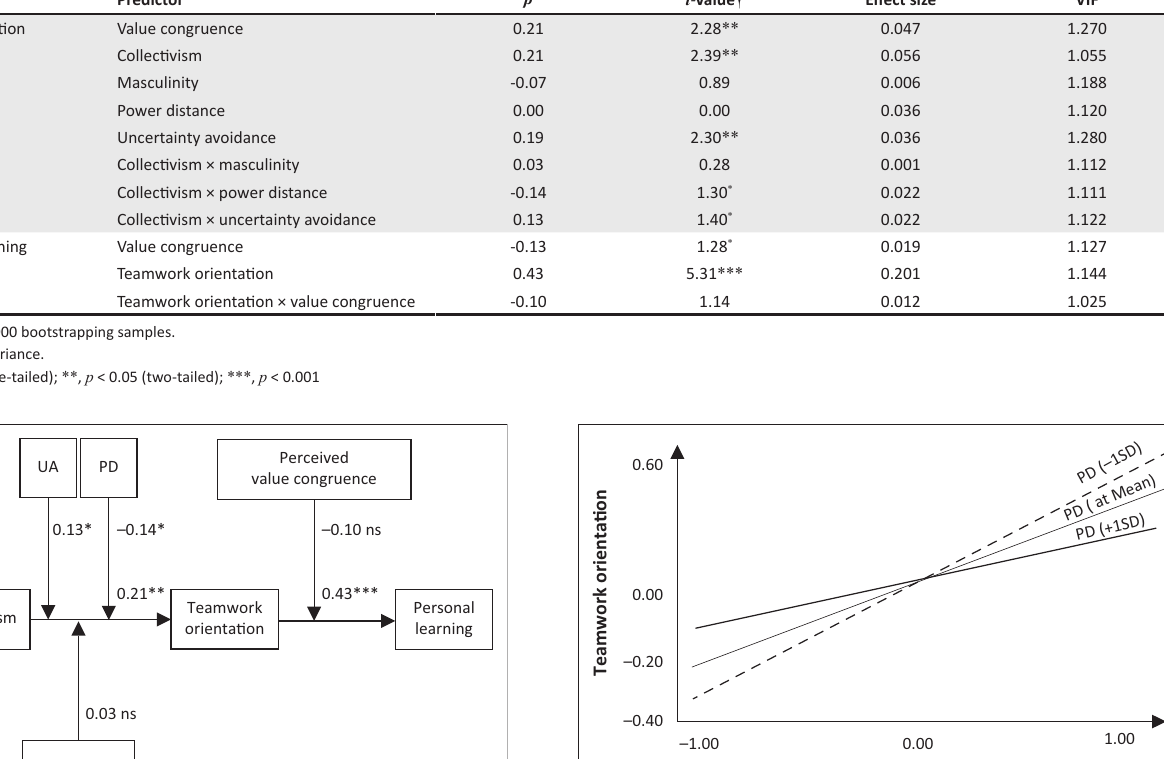
TABLE 4: Path coefficients, effect size and variance. Criterion